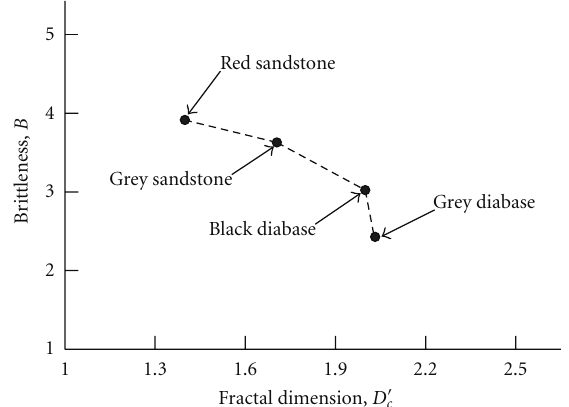
Figure 10: Corresponding relationship between fractal dimension and brittleness of rocks. Table 2: Typical rock brittleness obtained by experiment.